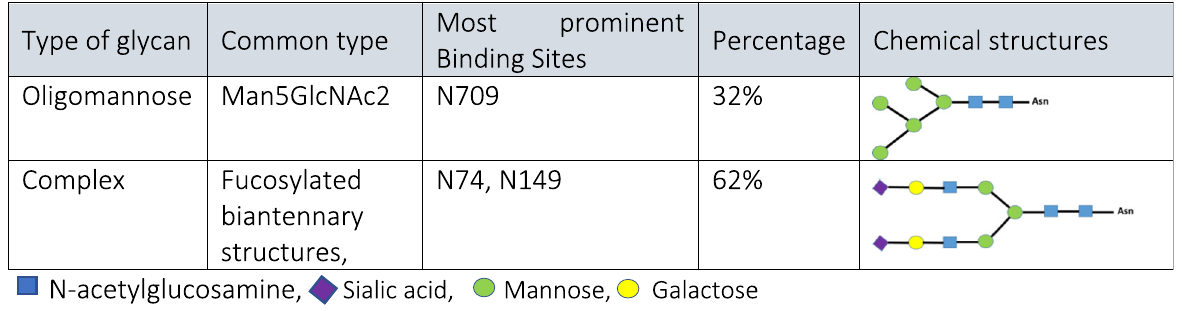
Table 1 Averaged compositions across all glycosylation sites of the SARS-CoV-2 S-protein and their schematic